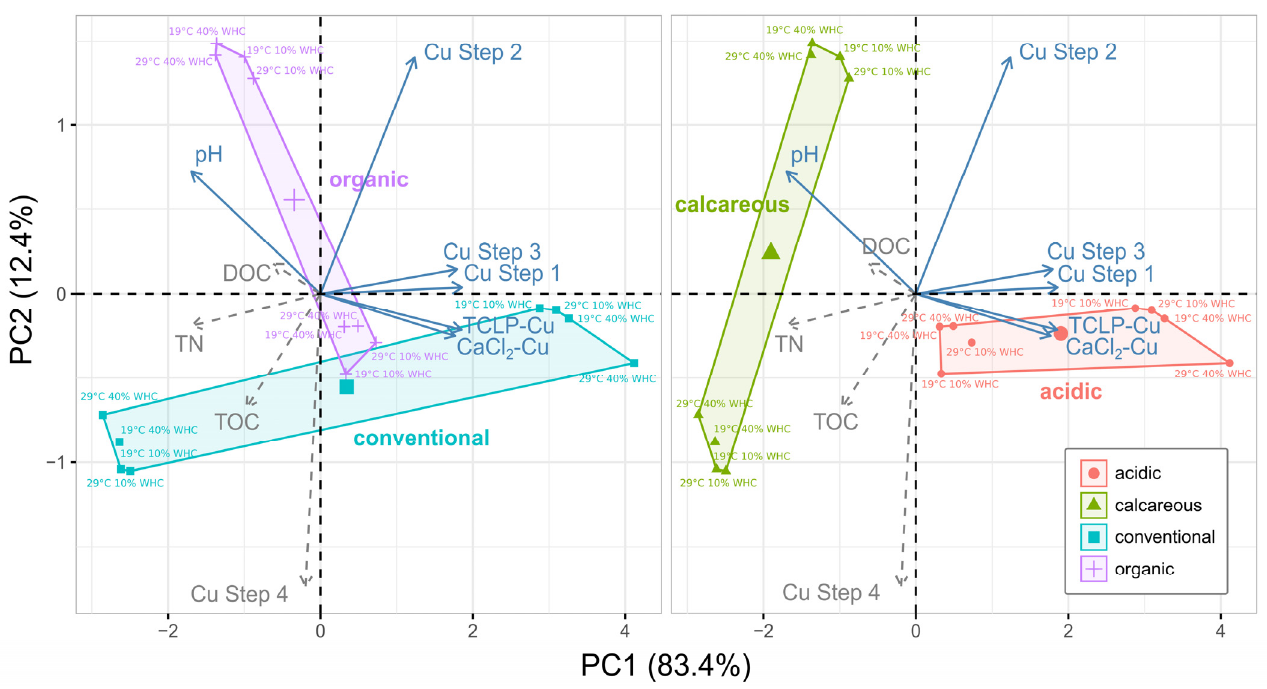
Figure 5. Principal component analysis of soil properties grouped by soil management type (organic vs. conventional) or soil pH (calcareous vs. acidic). The first two axes of the PCA explain 95.8% of the variance. Blue solid arrows are used for the ordination. Gray dashed arrows refer to descriptors (not influencing the ordination).